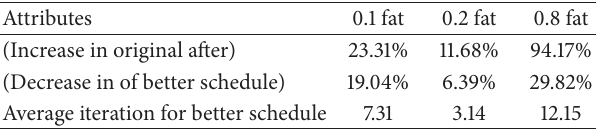
Figure 13: Results for DAGs with different widths. Table 5: Performance for DAGs with different widths.